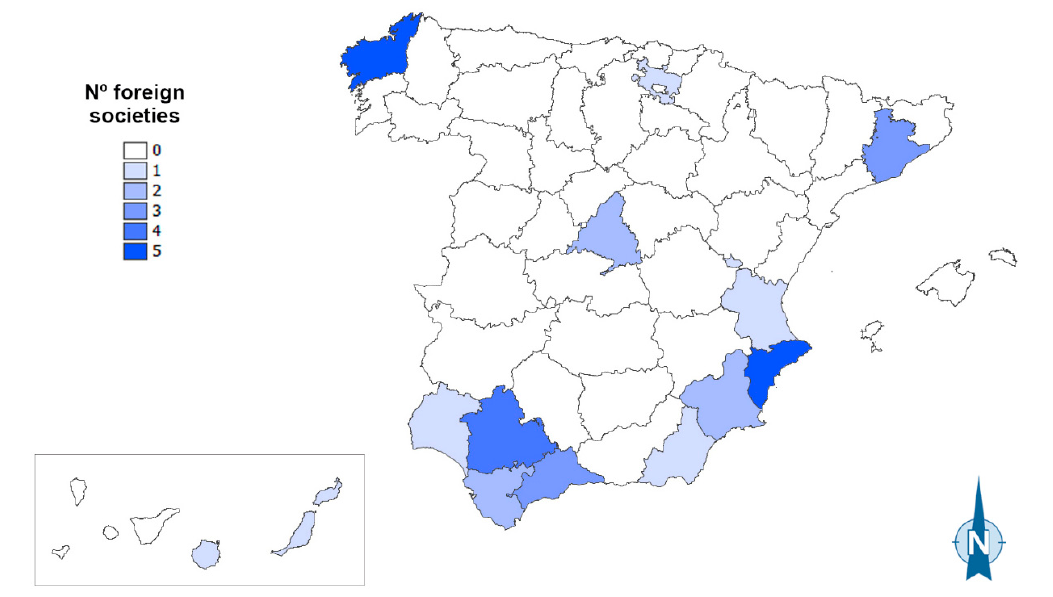
Figure 8. Regional distribution of foreign water companies (1853–1942).